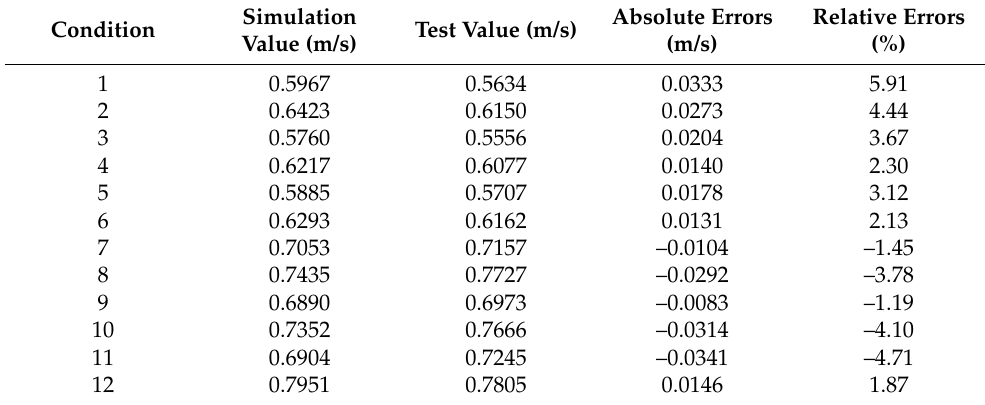
Table 5. The validation of v 1 .